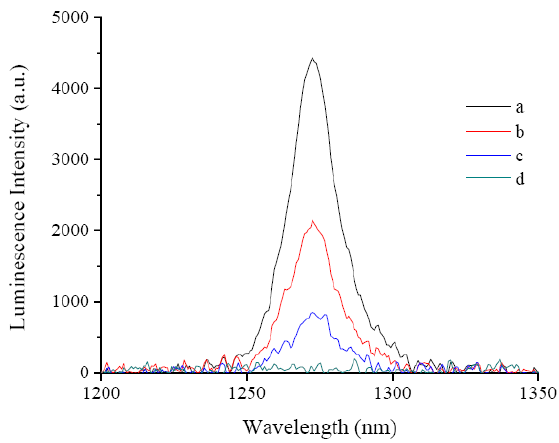
Figure 5. Singlet Oxygen Emission Spectra of Phenazine ( a ), TCMPOMO ( b ), Zn(II)TCMPOMO ( c ) and Cu(II)TCMPOMO ( d ) in